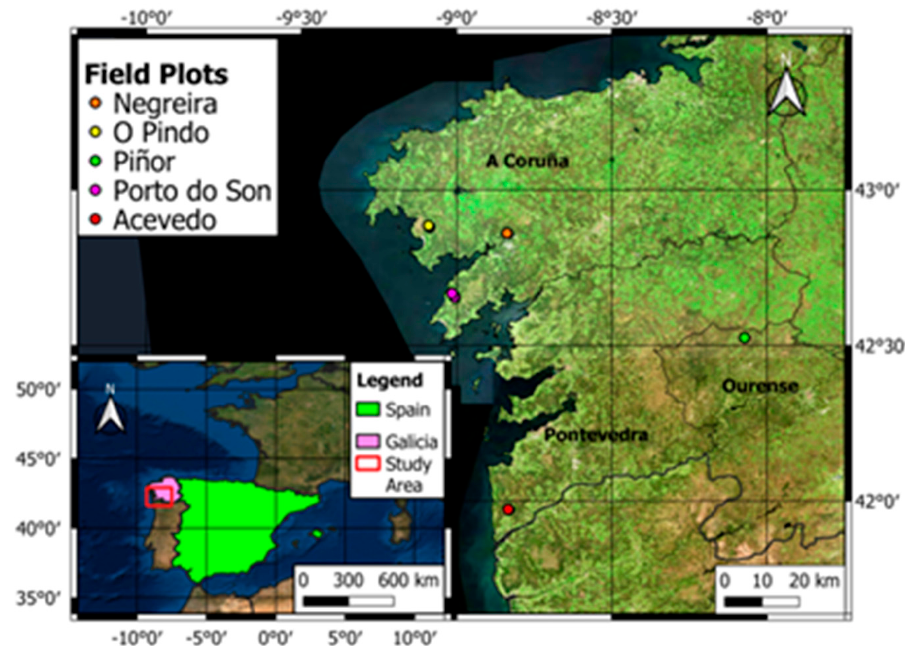
Figure 1. Location of the experimental sites within Galicia (NW Spain) affected by fires between 2009 and 2016. The reference coordinate system is WGS84 (EPSG: 4326). Table 1. Characteristics of the experimental sites .